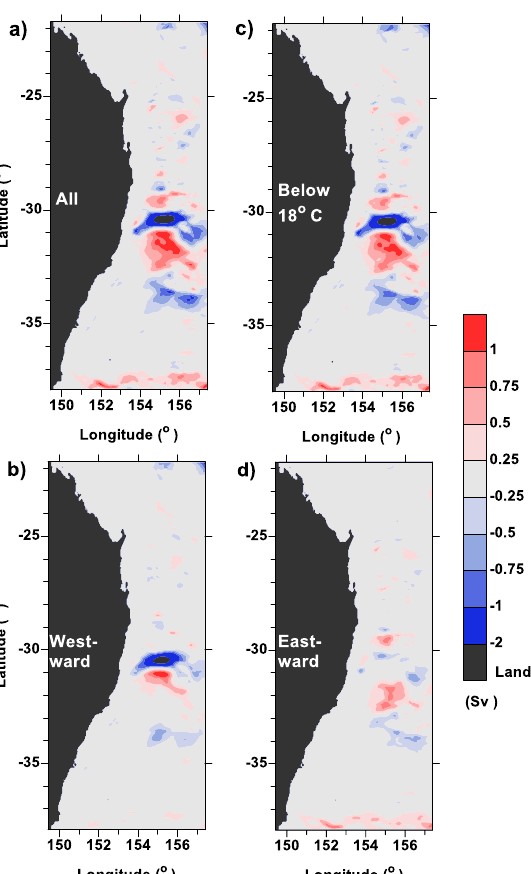
b for southward flows, c for flow of waters 18 °C or below, and d for northward flows Fig. 8 a Time series of the elevation at 30° S 154° 11’E indicating